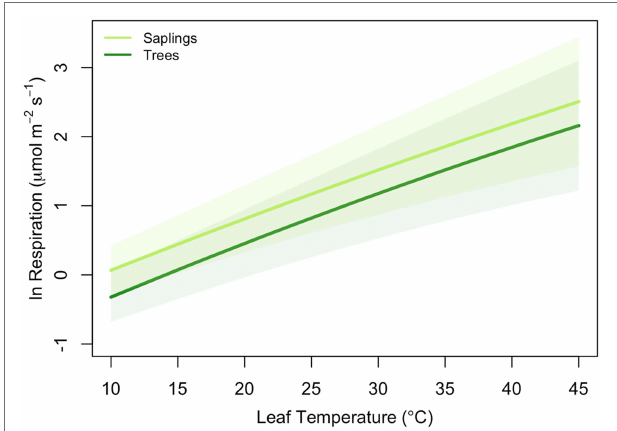
FIGURE 2 | Average model results (log of leaf respiration) for trees [ ≥ 10 cm diameter at breast height (DBH) – dark green] and saplings (5–10 cm DBH – light green) of Picea glauca growing in the FTE in Alaska. Line presents the mean response ( n = 36) and shaded area = 95% confidence interval for size class. Model parameters are presented in Table 2